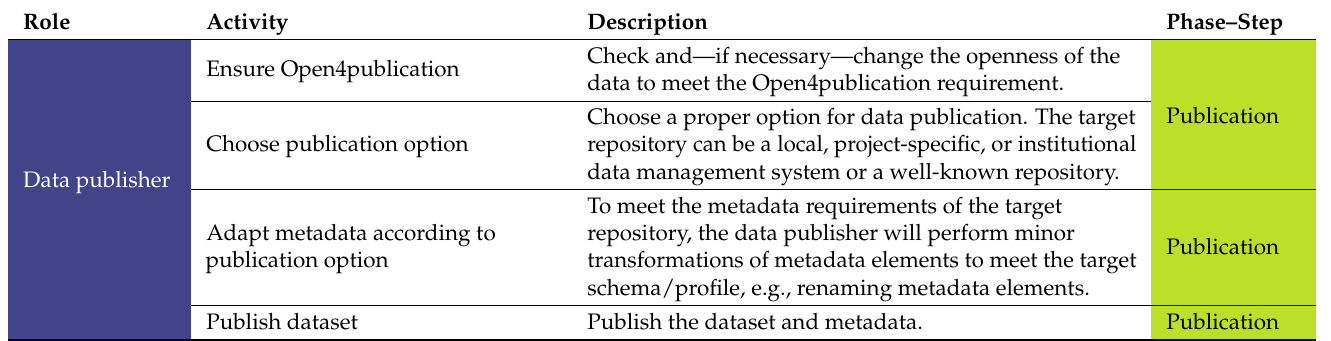
Table 13. Roles and their activities with descriptions at publication